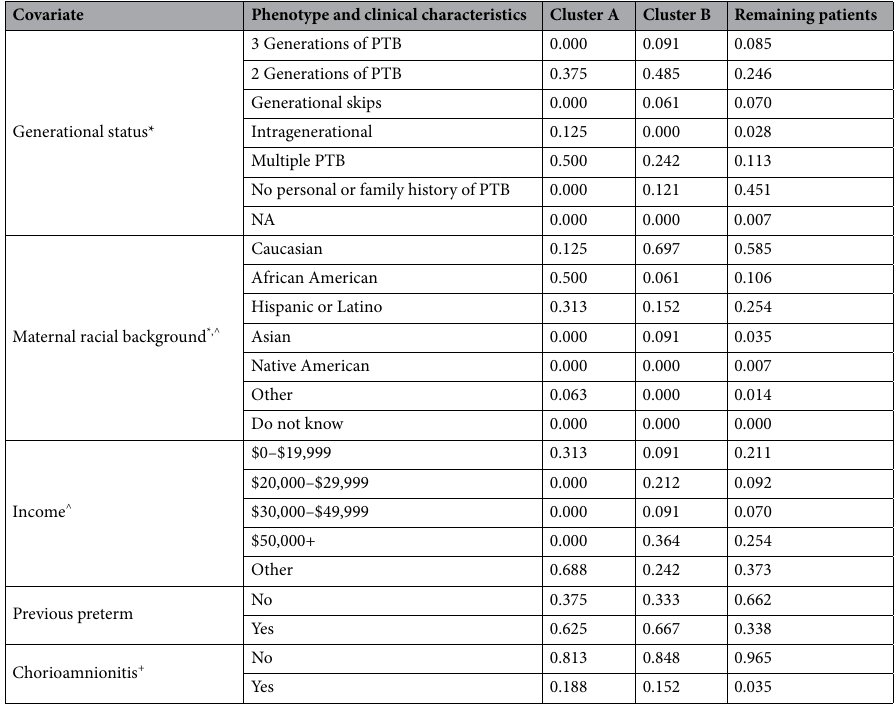
Table 6. Proportion of patient clinical characteristics within clusters. *p < 0.05, Cluster A vs remaining patients. + p < 0.05 Cluster B vs remaining patients. ^ p < 0.05 Cluster A vs Cluster